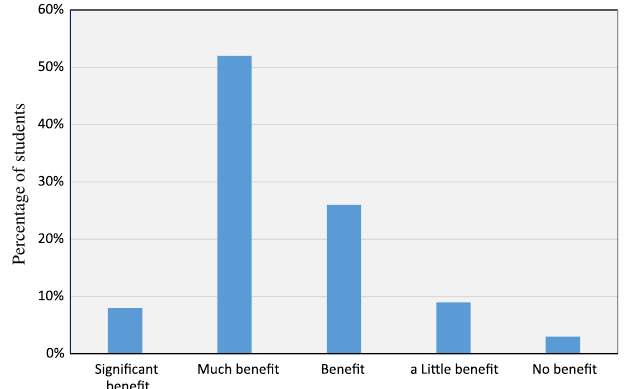
FIG. 2. Students ’ self-reporting on the extent to which they benefited from the DGWI